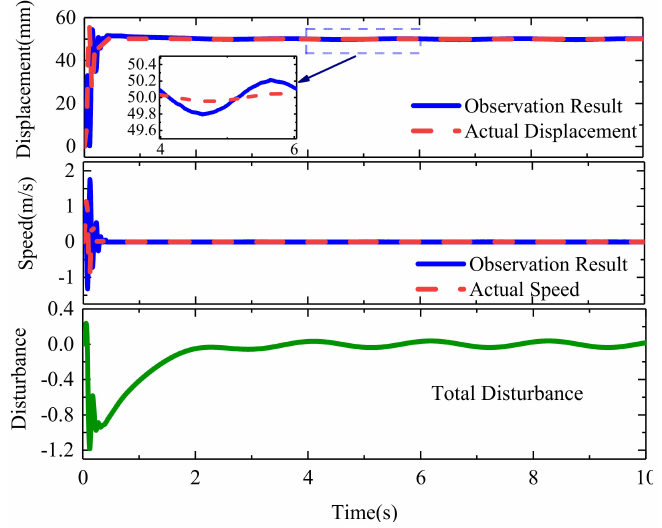
Figure 16. Observations by the ESO.